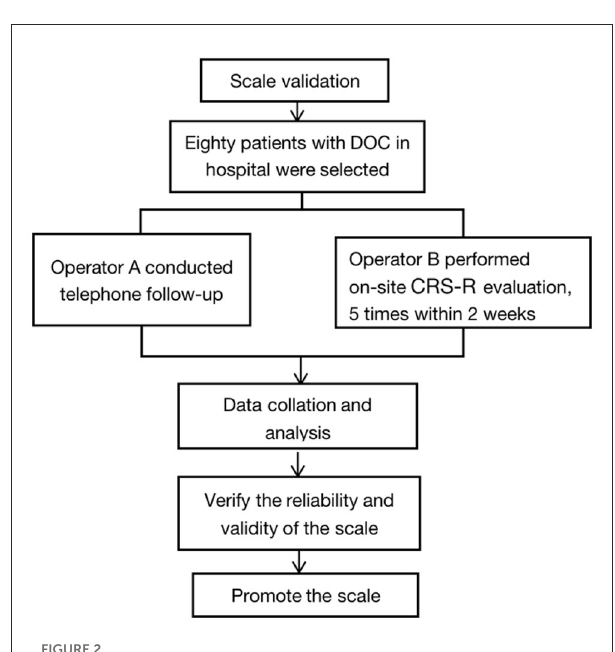
FIGURE2 Flow chart of scale